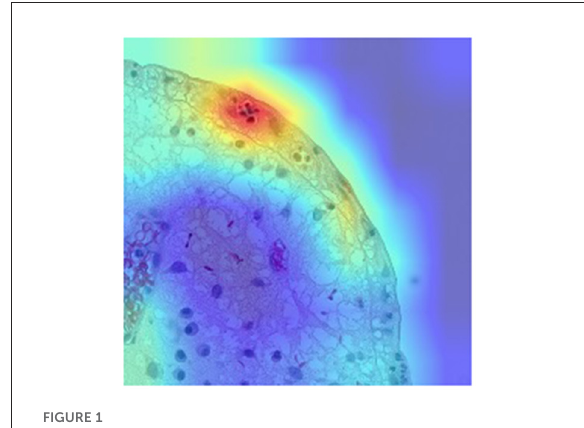
FIGURE1 AI-powered assessment of histological activity.